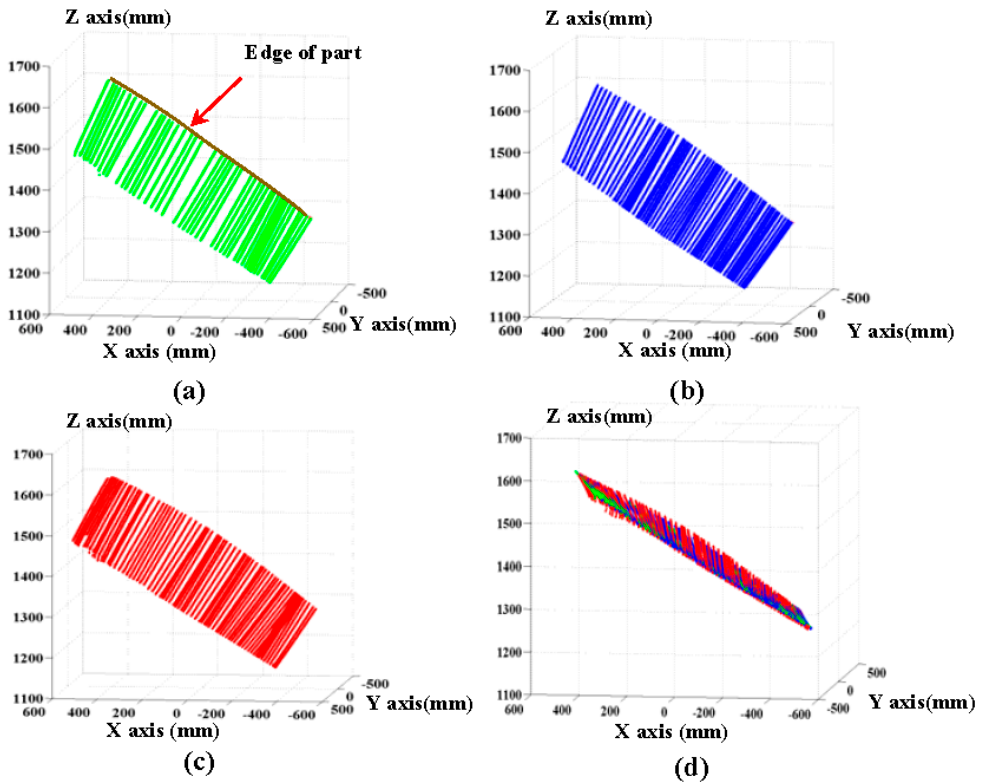
Figure 16. The reconstruction results under different loads: ( a ) the load of 0 N; ( b ) the load of 30 N; ( c ) the load of 50 N; ( d ) the loads of 0 N, 30 N and 50 N.